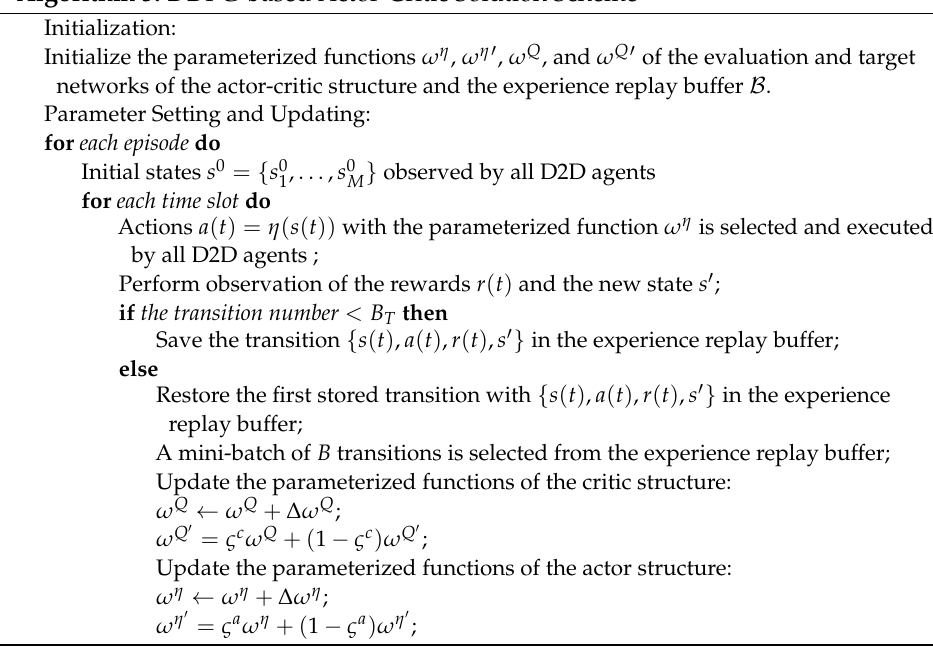
Algorithm 3: DDPG-based Actor-Critic Solution